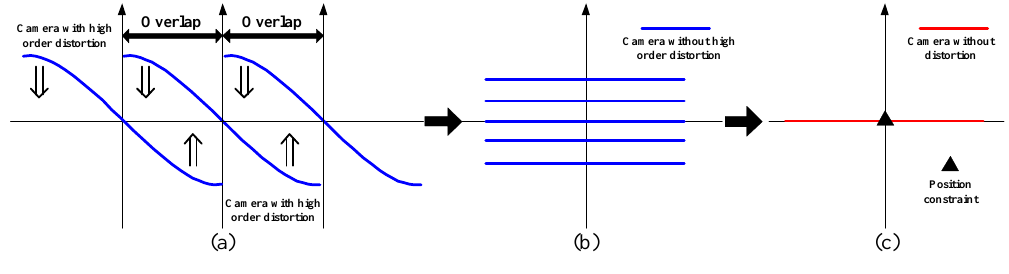
Figure 2. Description of auto internal calibration using mutual constraint of overlapped